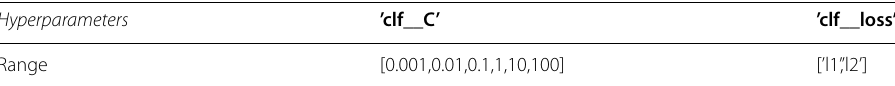
Table 11 Hyperparameters optimized for LG